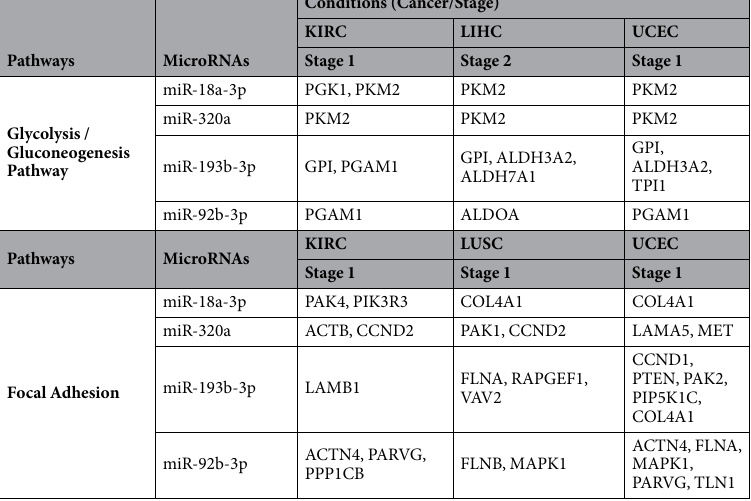
Table 3. An illustration on a 4-miRNA module (miR-18a-3p, -320a, -193b-3p and -92b-3p) that regulates two signaling pathways in three conditions. Gene targets are listed for each pathway and each